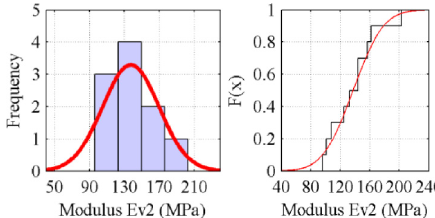
Fig. 11. Histogram of the modulus of deformation values identified using plate bearing test results on crushed aggregate base course (Fig. 4, Level: -I) including continuous and discrete distribution function